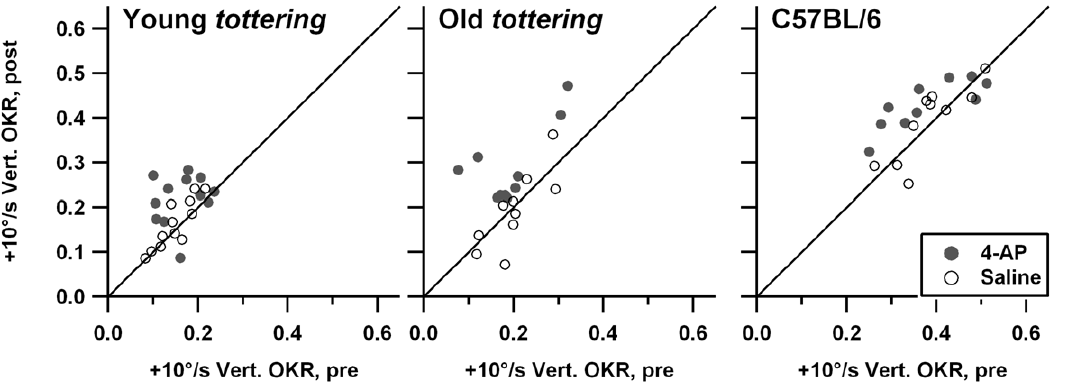
Figure 8. Comparison of response to + 10 6 /s constant-velocity roll optokinetic stimulation before and after saline or 4-AP, in the format of Figure 1. These data generated the + 10 u /s points in the averaged speed tuning data of Figure 7. The scatterplots indicate that the 4-AP effect seen in the average tuning curves derived from multiple sessions, and not from a very few outliers.